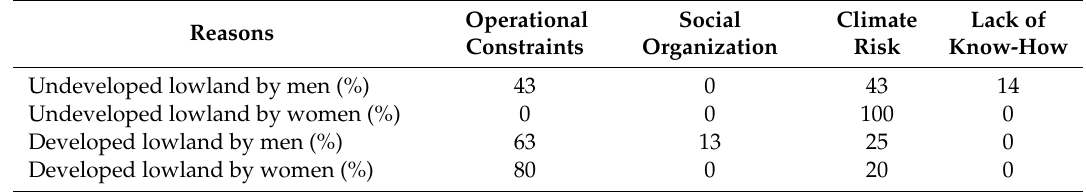
Table 1. Reasons for the choice of sowing (rather than transplanting) in 2017, according to gender and situation. Operational Social Climate Lack of Reasons Constraints Organization Risk Know-How Undeveloped lowland by men (%) 43 0 43 14 Undeveloped lowland by women (%) 0 0 100